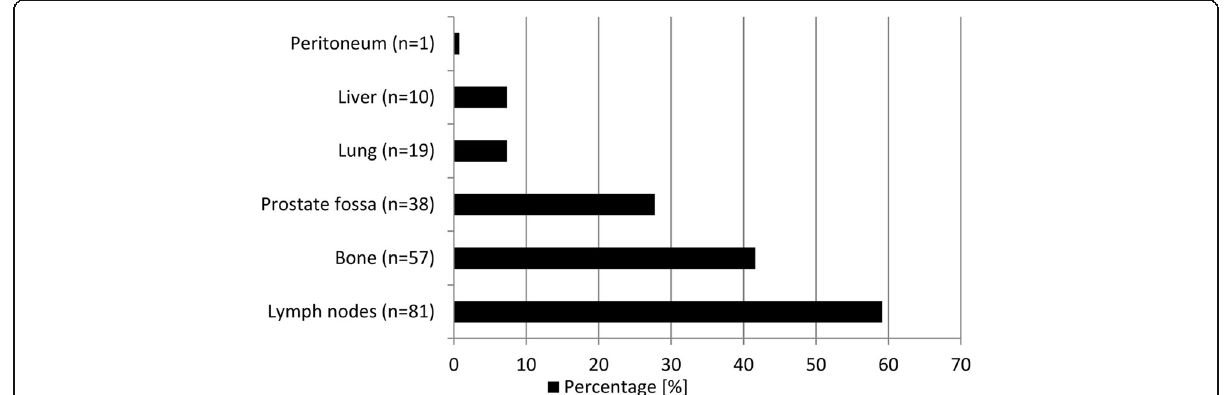
Fig. 2 Location of tumor tissue in 137 PSMA-positive scans